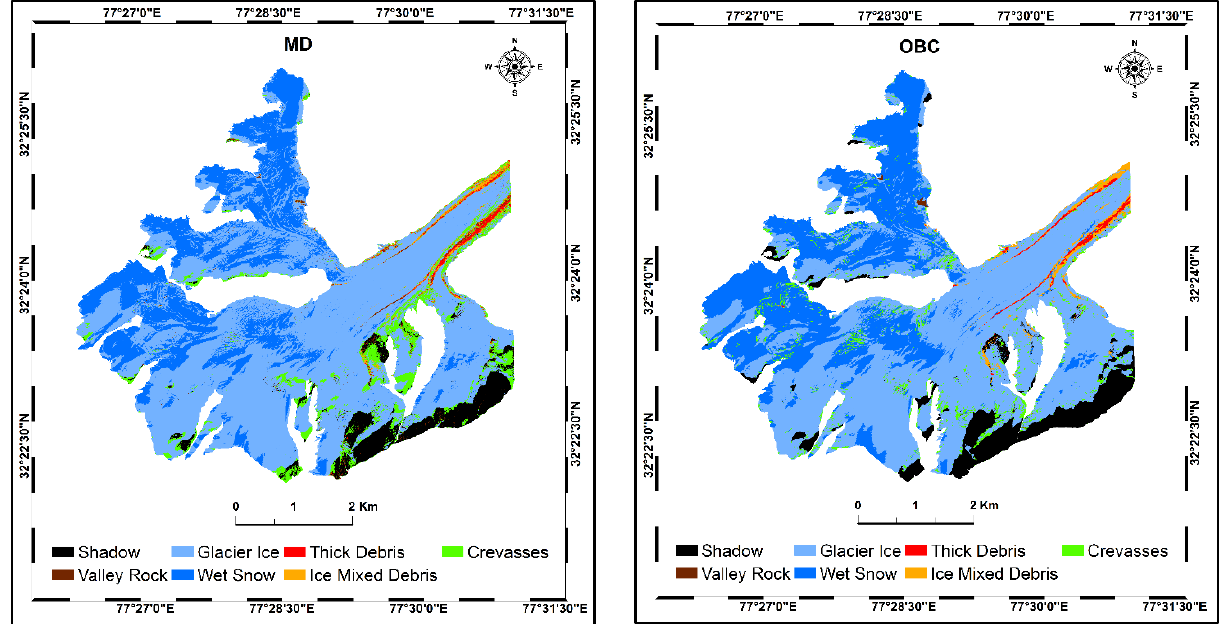
Figure 6. Object based classification